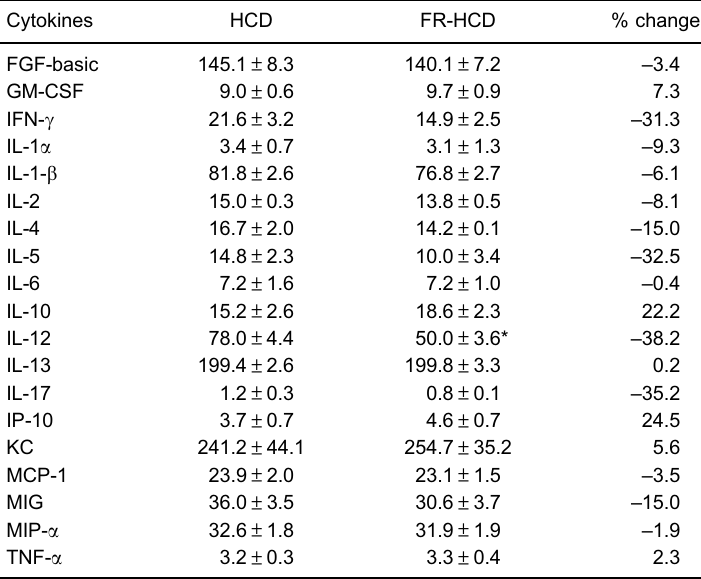
Table 2. Serum levels of cytokines (pg/mL) in freely fed high-carbohydrate diet (HCD) or food restricted high-carbohydrate diet (FR-HCD) mice for 56